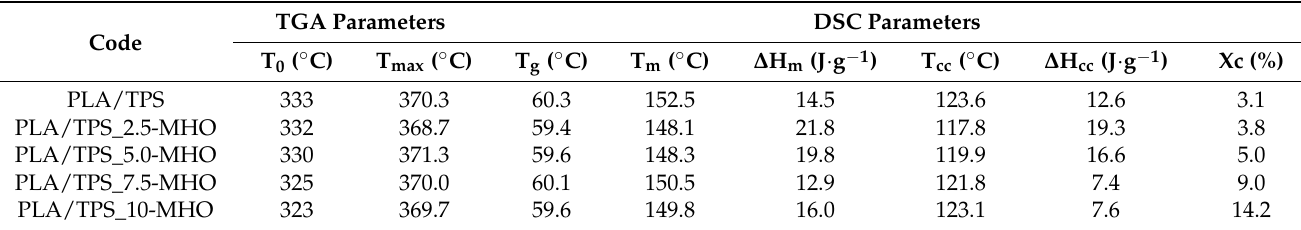
Figure 5. Thermal decomposition of PLA/TPS blend unplasticized and plasticized with different amounts of MHO content: ( a ) thermogravimetry (TG) weight loss and ( b ) differential thermogravimetry (DTG) first derivative curves. Table 2. Summary of the TGA and DSC thermal parameters of PLA/TPS blend unplasticized and plasticized with different amounts of MHO